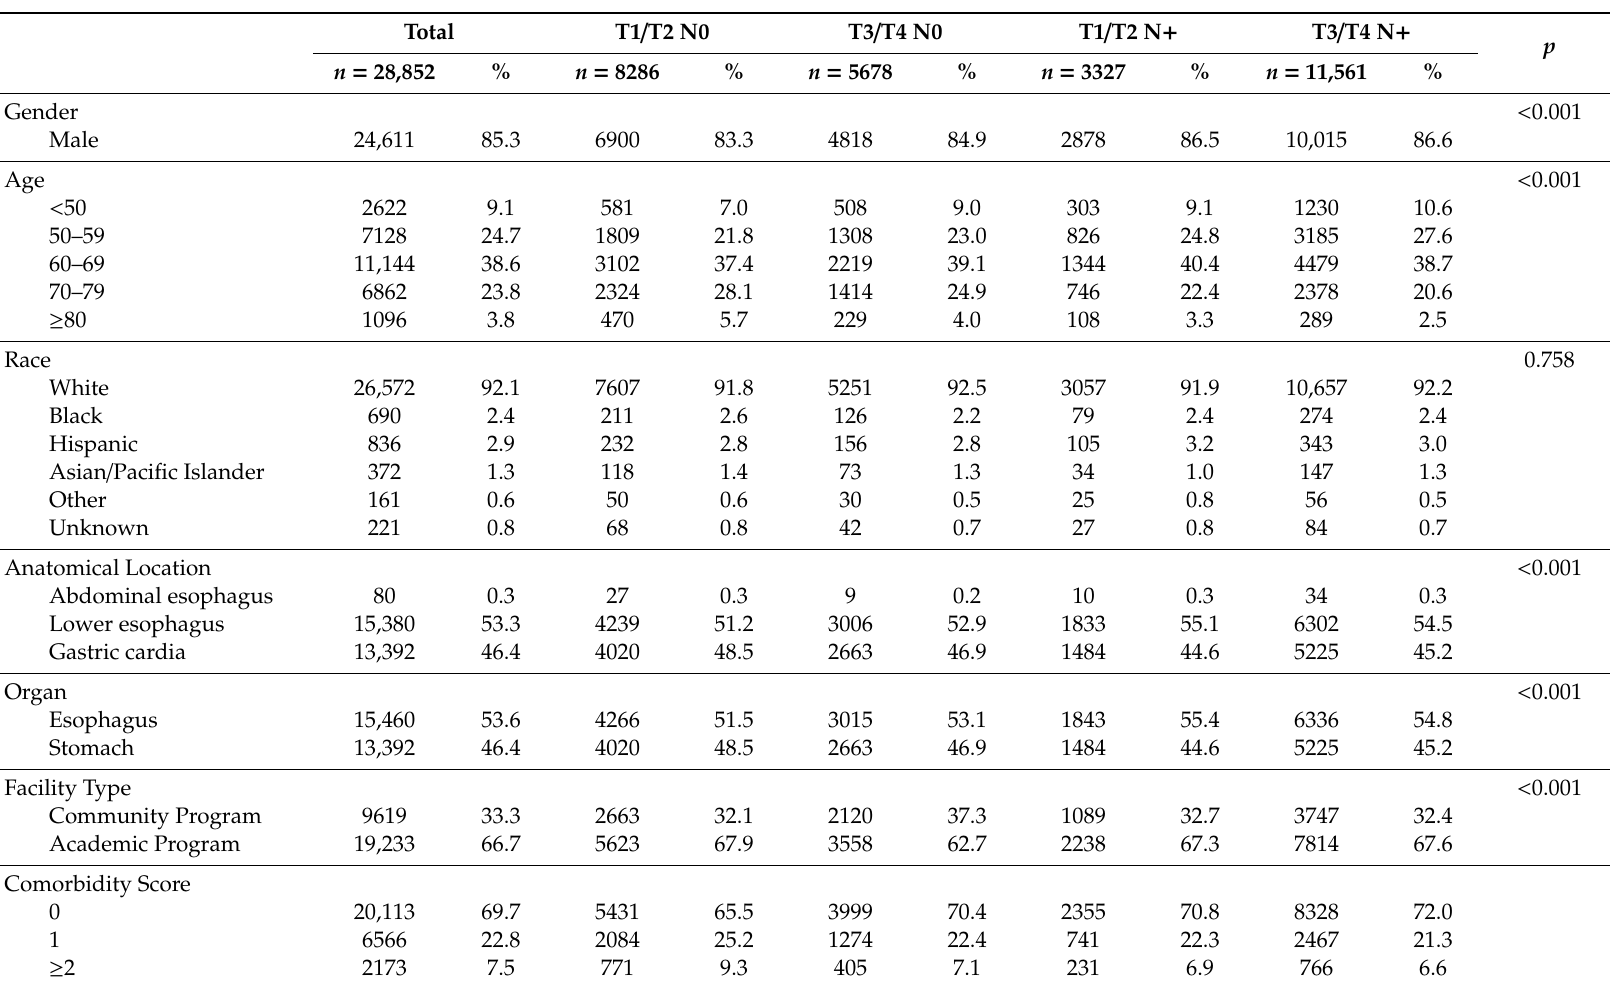
Table 2. Demographic, clinical, and treatment variables for patients who underwent resection of gastroesophageal junction adenocarcinoma tumors by clinical